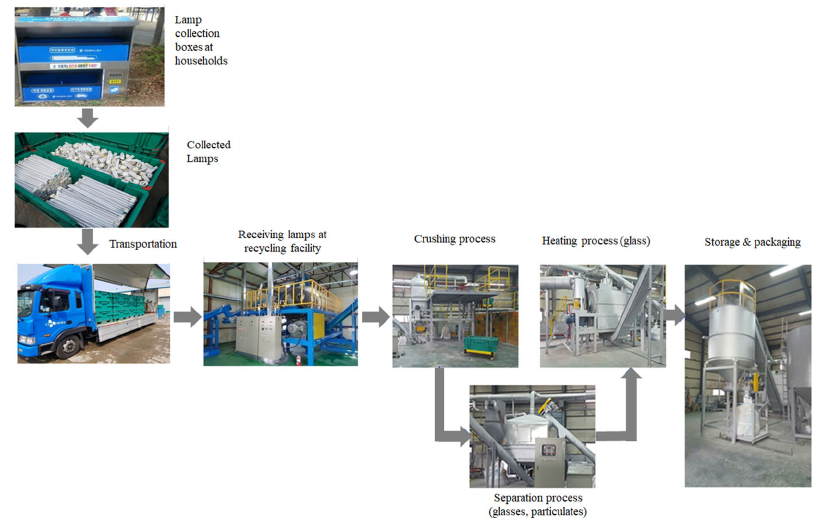
Figure 1. The recycling and management system of fluorescent lamps in South Korea.